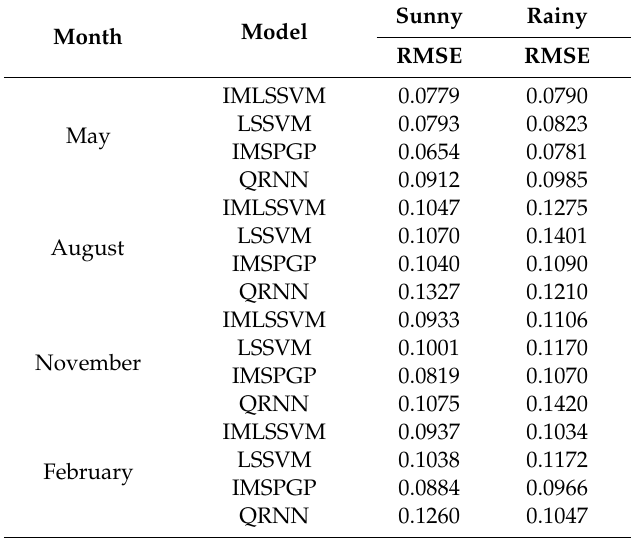
Table 3. Comparison of point prediction results in May, August, November, and February.